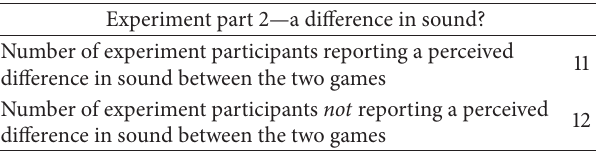
Table 6: Numbers of experiment participants that did or did not perceive any difference in the sound between the two versions of the game after part